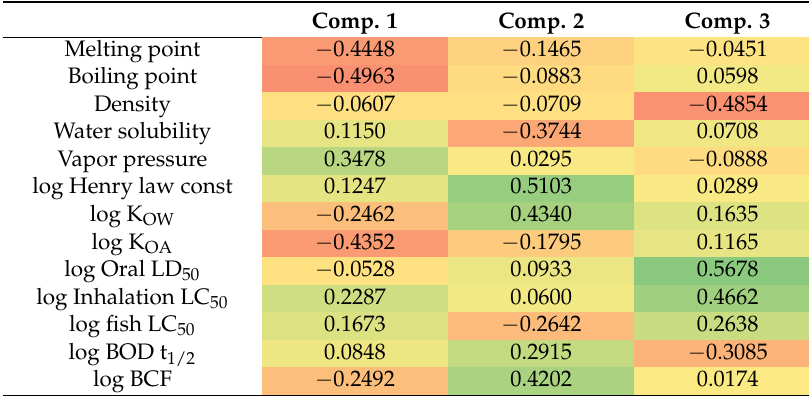
Table 2. The results of data treatment with principal component analysis. Dark red is for very negative values, yellow is for neutral values and green stands for positive